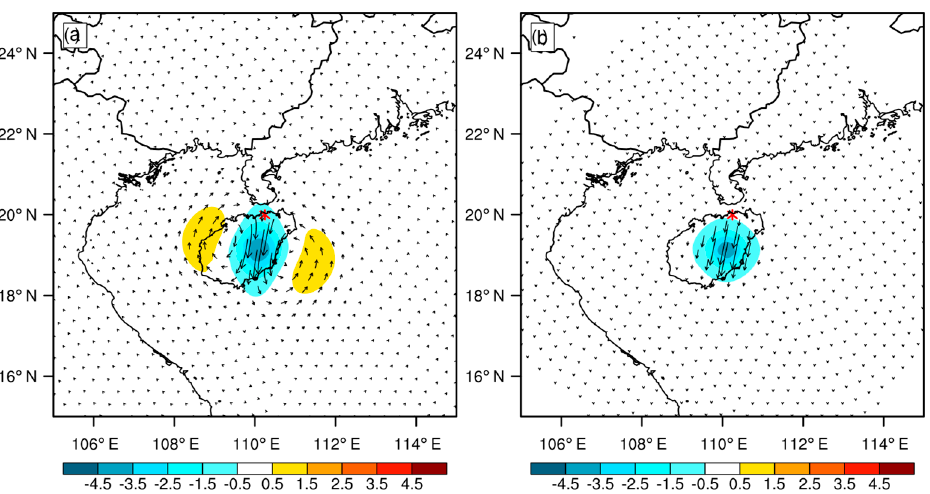
Figure 5. The increments of y-component wind speed with units as m s − 1 and wind vector on 700 hPa in single observation experiments (( a ) DA_ ψχ ; ( b ) DA_UV). The radar locations (red asterisks) of HKRD are also indicated.